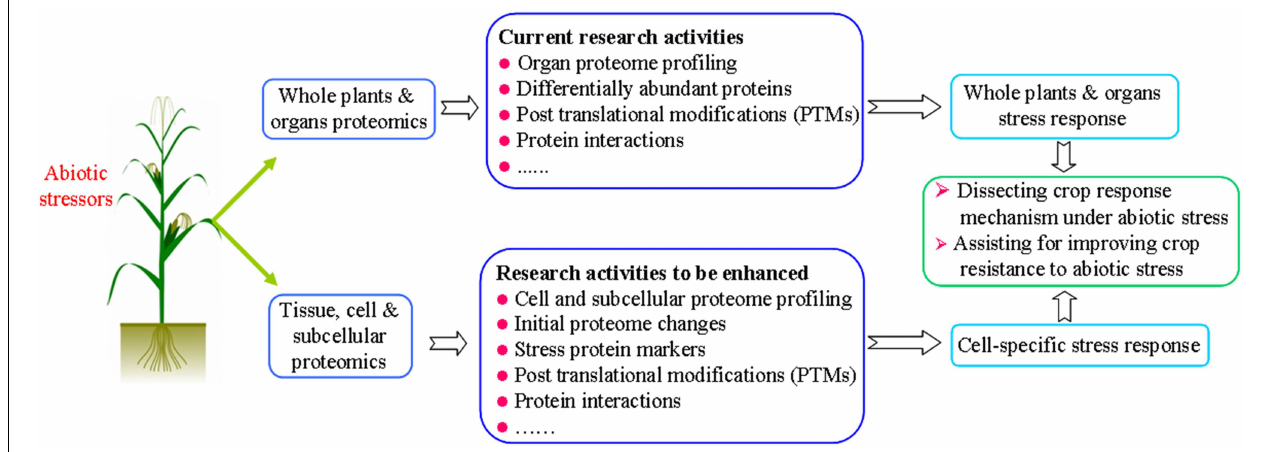
FIGURE 1 | A graphic summary on current research and future research in proteomic analysis of crop plants under abiotic stress